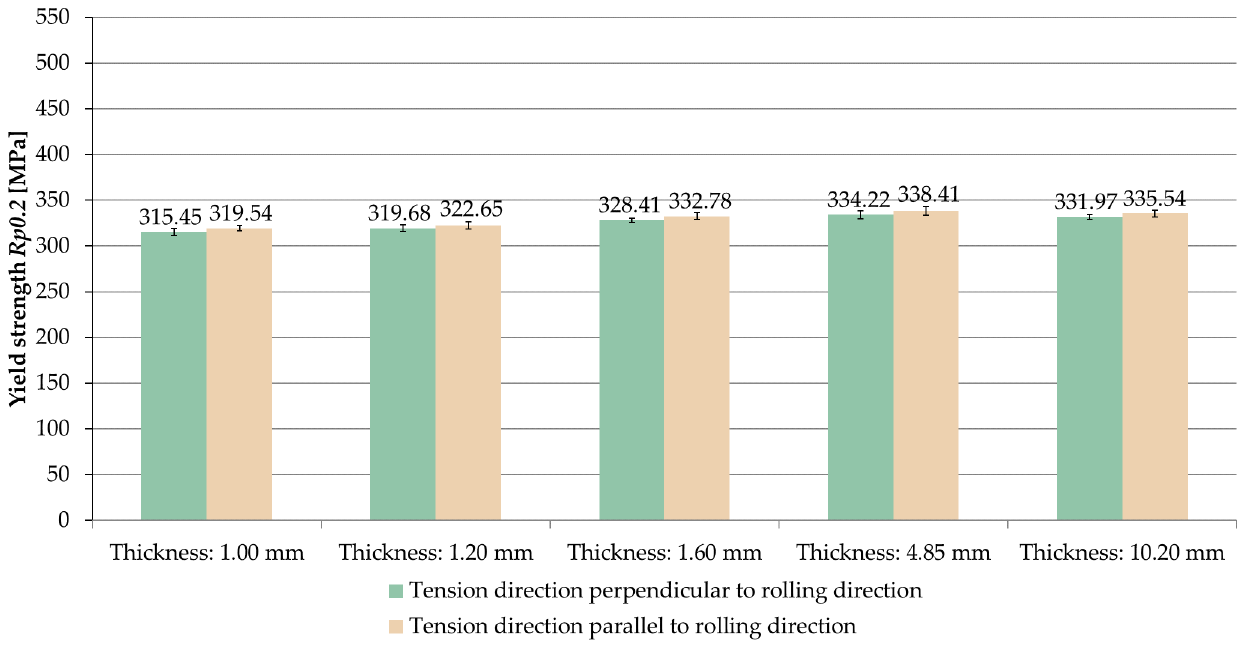
Figure 10. Comparison of ultimate tensile strength UTS R m for samples stretched parallel to the rolling direction. On the basis of the obtained results, it was found that the ultimate tensile strength UTS R m increased with increasing sample thickness, but only up to a certain point. The maximum value was recorded at a thickness of 4.85 mm, for which the ultimate tensile strength UTS was R m = 474.70 MPa (perpendicular direction) and R m = 479.10 MPa (parallel direction). The averaged values of yield strength R p 0.2 obtained for the tested sample thicknesses and the relationships between the tension direction and the rolling direction are shown in Figure 11.